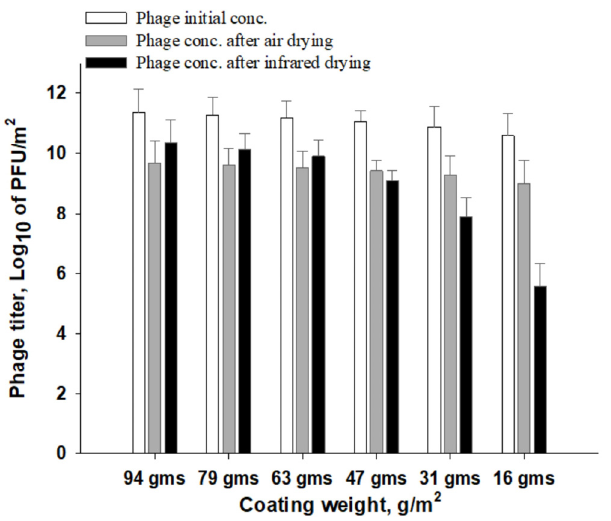
Figure 9. Effect of coating weight and drying method on phage infectivity as a result of initial phage concentration (white), phage concentration after air-drying (gray) and phage concentration after IR-drying (black).